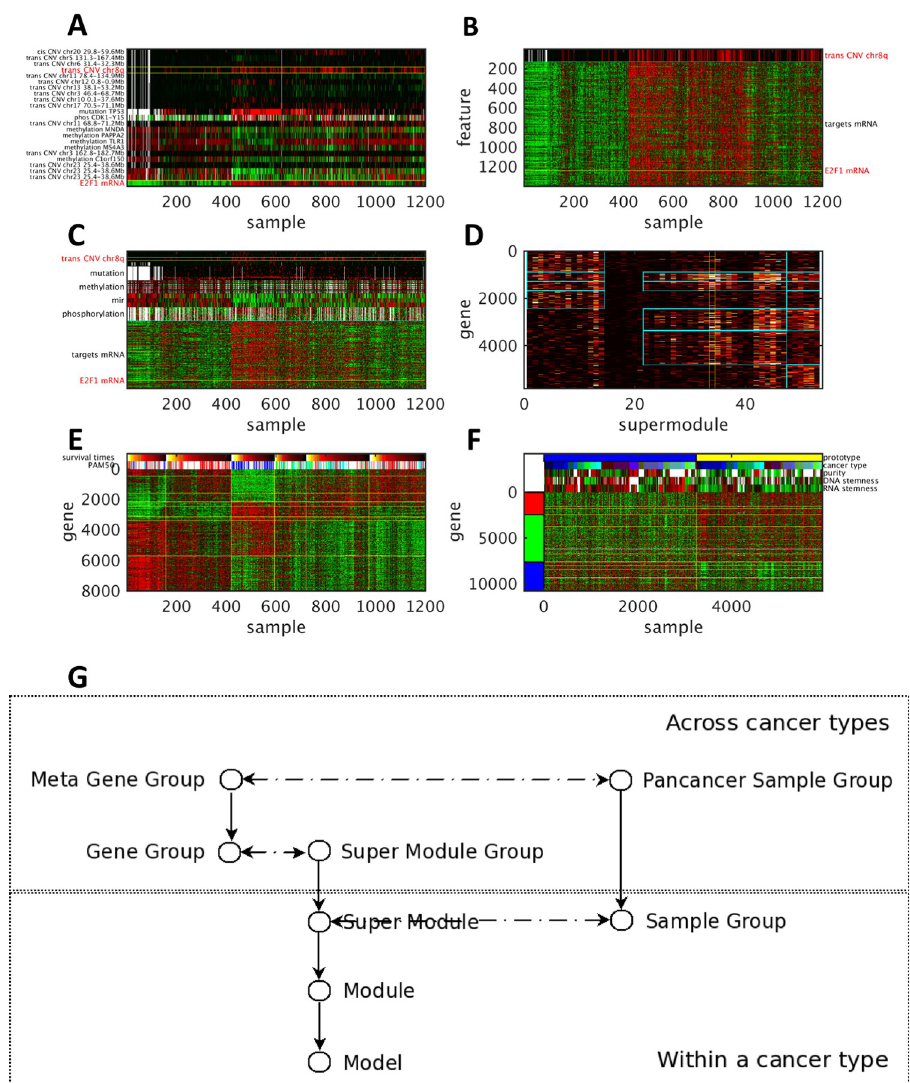
Fig 1. An illustration of integrated hierarchical association structure from BRCA and other cancer types of TCGA data. A : The Association Model of E2F1 as the target gene in TCGA BRCA data. The effectors and target of the Model are annotated. The bottom row displays its target gene expressions across 1201 samples, and all the other rows display the effector variations of the Model. One effector–chr8q CNV–is marked by yellow boundaries. The effector variations and target gene expression values are normalized in [0,1]. Red and green entries indicate high (1) and low (0) values respectively, and dark entries indicate the intermediate values (0.5). B : The Association Module of chr8q CNV as the effector. The top row displays chr8q CNV, and all the other rows display the target gene expressions. E2F1 gene expressions are marked by a yellow line. C : The effector variations (upper rows) and target gene expressions (lower rows) of a BRCA Super Module. Effectors and targets are separated by a cyan boundary. Effectors are sorted top-down by the types of associations in the following order: trans-acting CNVs, mutations, DNA methylations, microRNA expressions, and protein phosphorylations. Chr8q CNV and E2F1 gene expressions are marked by yellow boundaries. D : The membership occurrence matrix of 7 Gene Groups in 4 Super Module Groups including the BRCA Super Module in panel C . The heat color of each entry reflects the number of Modules that contain a gene (a row) and belong to a Super Module (a column). The column of the BRCA Super Module in panel C is marked by yellow boundaries. The occurrence of E2F1 in the BRCA Super Module is marked by a blue bar. A rectangular patch marked by cyan boundaries indicates the over-representation of a Gene Group in a Super Module Group. E : The combinatorial expressions of Super Modules and Sample Groups in BRCA data and their alignments with clinical phenotypes. Genes are included if they appear in at least 10 Association Modules in any Super Module. Eight Super Modules and six Sample Groups are demarcated by yellow horizontal and vertical lines respectively. The sorted samples are aligned with four PAM50 subtypes of breast cancer (blue: basal-like, green: HER2-enriched, red: luminal A cyan: luminal B)